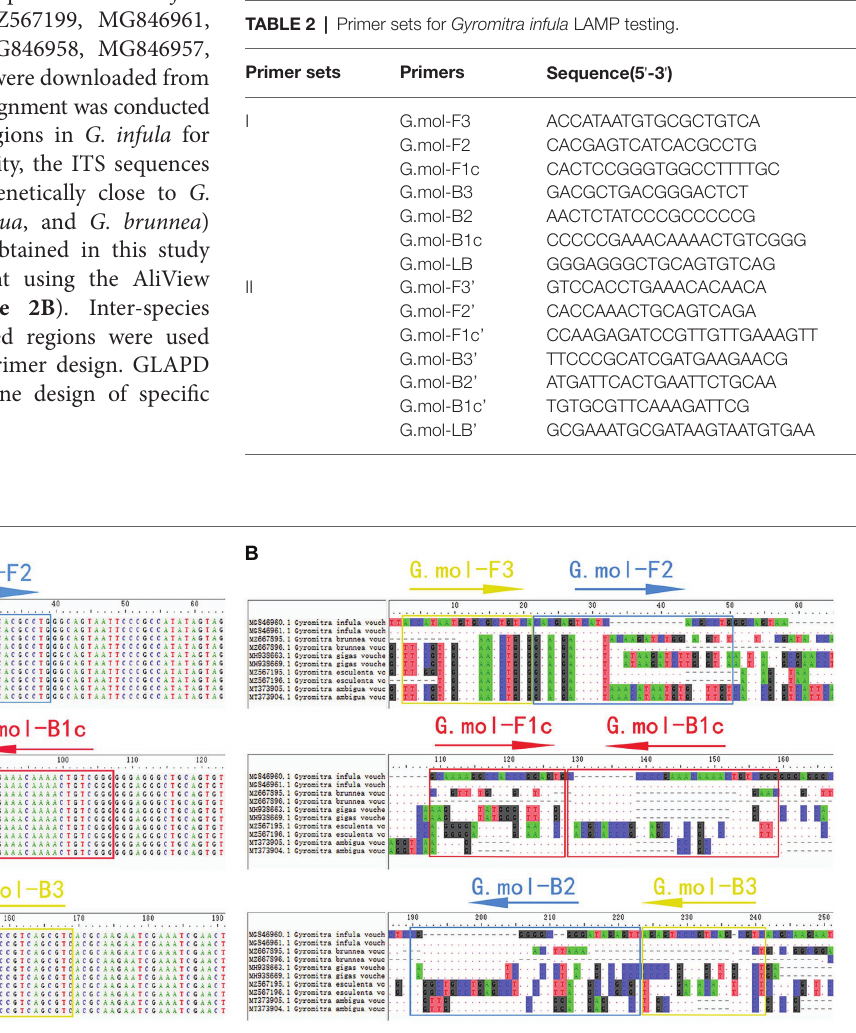
FIGURE 2 | The LAMP primer set of Gyromitra infula designed in the ITS region. (A) The multiple-sequence alignment of Gyromitra infula homologous species. (B) The multiple-sequence alignment of Gyromitra infula similar or related species (not all shown in the picture).